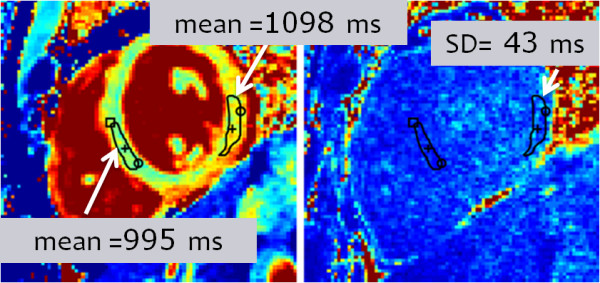
Example T1-map and SD map for subject with myocarditis and focal abnormality corresponding to T1 elevation (103 ms) between lateral wall and septum of 2.4 SD on a pixel-wise basis (lateral wall SD = 43 ms).